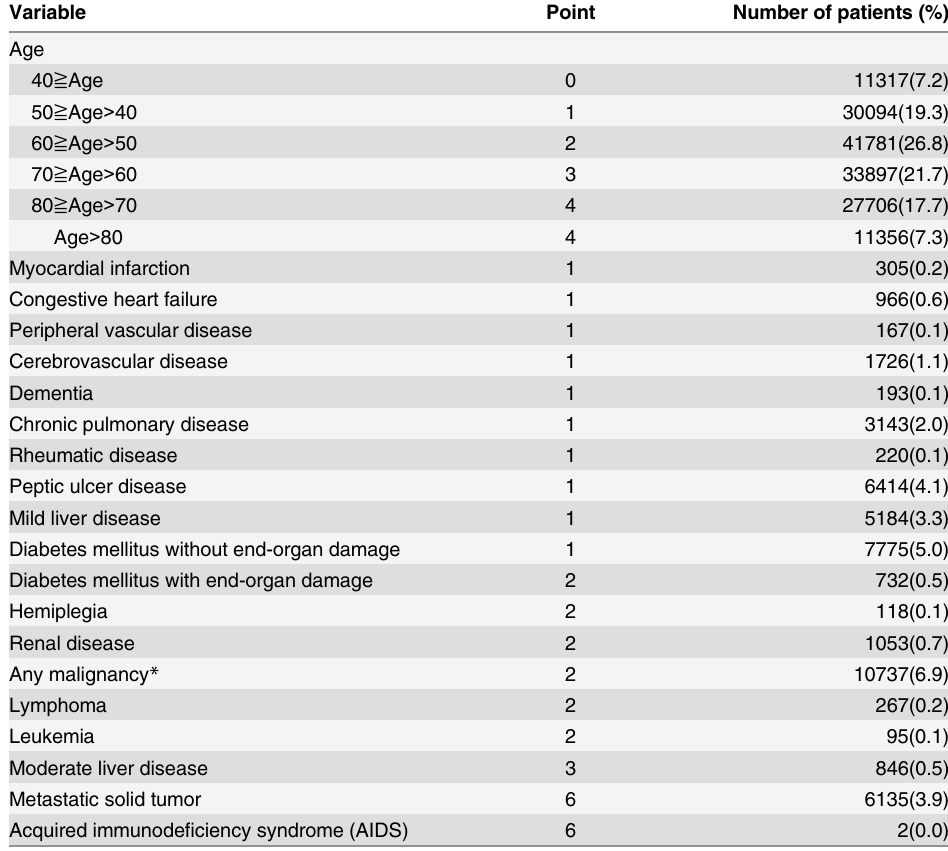
Table 1. Comorbidity distribution based on the age-adjusted Charlson comorbidities, n = 156,151.